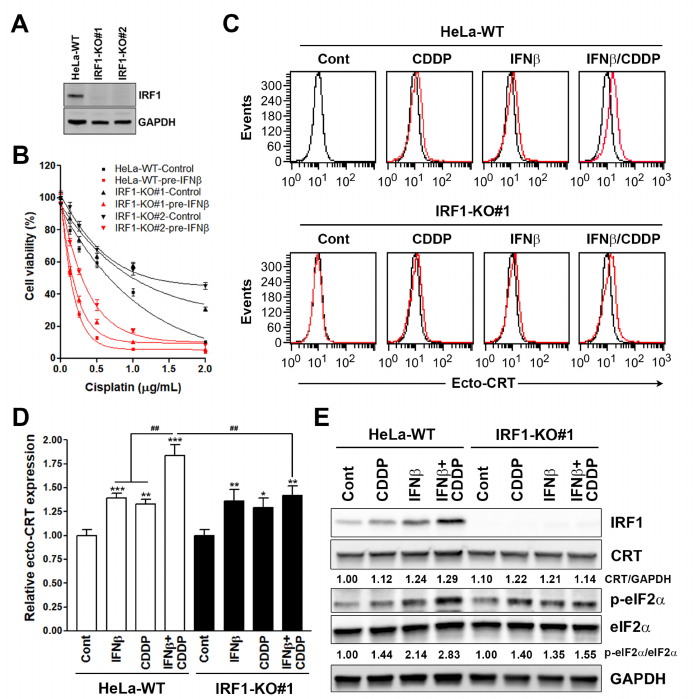
Figure 6. E ff ects of interferon regulatory factor 1 (IRF1) knockout on sequential interferon β (IFN β )-cisplatin treatment-induced cell viability inhibition and immunogenic cell death (ICD) biomarker expression in HeLa cells. ( A ) The IRF1 expression in IRF1-knockout (IRF1-KO#1 and IRF1-KO#2) and parental wildtype (WT) HeLa cells was analyzed by Western blotting. ( B ) IRF1-knockout (IRF1-KO#1 and IRF1-KO#2) and parental (WT) HeLa cells were treated with 100 ng / mL IFN β for 48 h, and then cells were replated in 96-well plates and treated with the indicated doses of cisplatin for 72 h. Cell viability was examined by MTT assay. ( C ) IRF1-knockout (IRF1-KO#1) and parental (WT) HeLa cells were sequentially treated with 100 ng / mL IFN β for 24 h and 2 µ g / mL cisplatin for another 24 h. Surface CRT (ecto-CRT) staining was performed and analyzed by flow cytometry. The mean fluorescence intensity in each treatment (the red line) was compared with that in untreated parental HeLa cells (the black line). ( D ) The mean fluorescence of ecto-CRT in ( C ) was quantified and plotted. p < 0.05 (*), p < 0.01 (** or ## ) and p < 0.001 (***) indicate significant di ff erences compared to control samples or the indicated group. ( E ) IRF1-knockout (IRF1-KO#1) and parental (WT) HeLa cells were sequentially treated with 100 ng / mL IFN β for 24 h and 2 µ g / mL cisplatin for another 4 h. Protein expressions were analyzed by Western